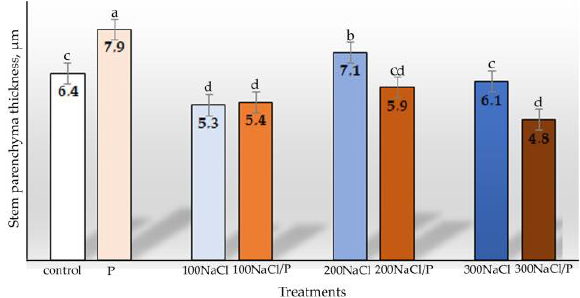
Figure 6. Dependence of stem parenchymal tissue thickness of young Chenopodium quinoa on stress conditions. The values shown are means (±SD). Different letters above the bars indicate a significant difference within the chart (between different stress intensities).